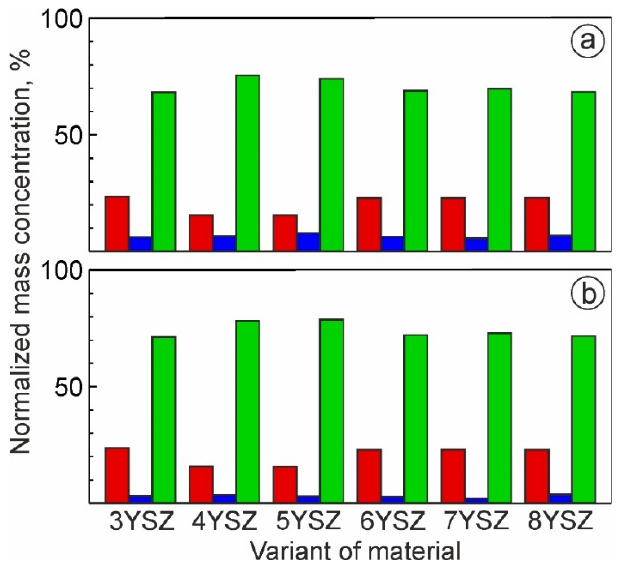
Figure 7. Normalized mass concentration of oxygen (red bars), yttrium (blue bars), and zirconium (green bars) for six studied materials with 3–8% Y 2 O 3 : ( a ) high yttrium content in large grains and ( b ) low yttrium content in small grains.